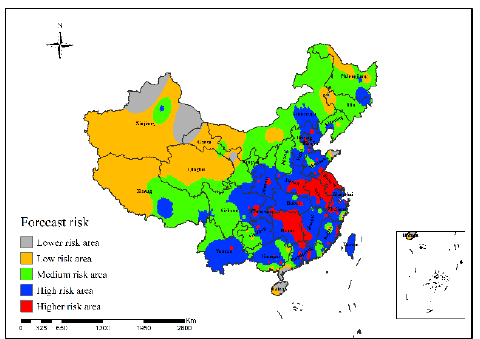
Figure 17. Risk simulation results of H7N9 outbreaks in China in 2017.